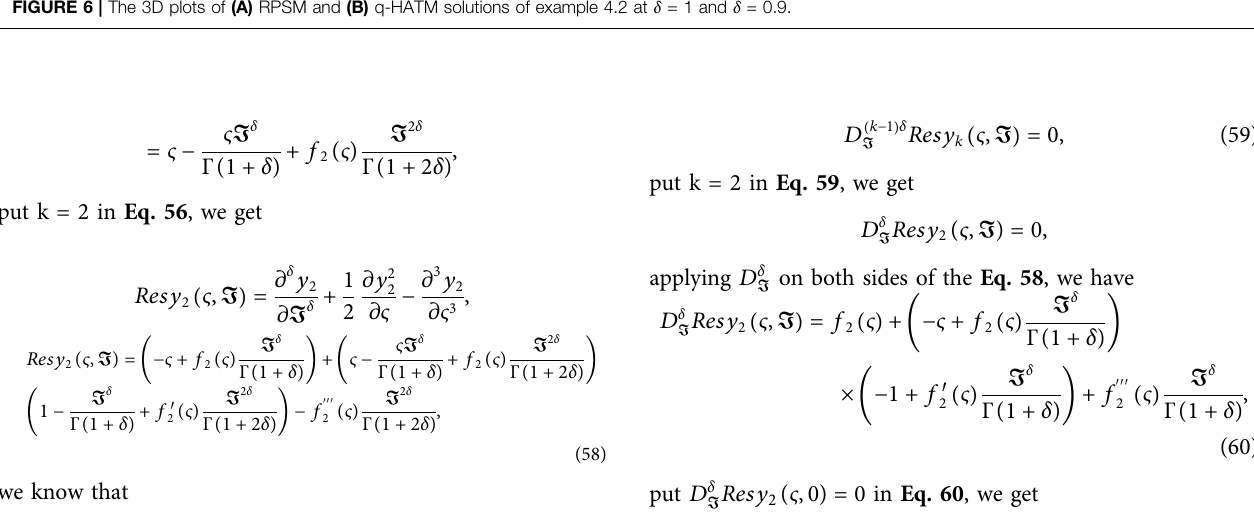
FIGURE 6 | The 3D plots of (A) RPSM and (B) q-HATM solutions of example 4.2 at δ = 1 and δ = 0.9.